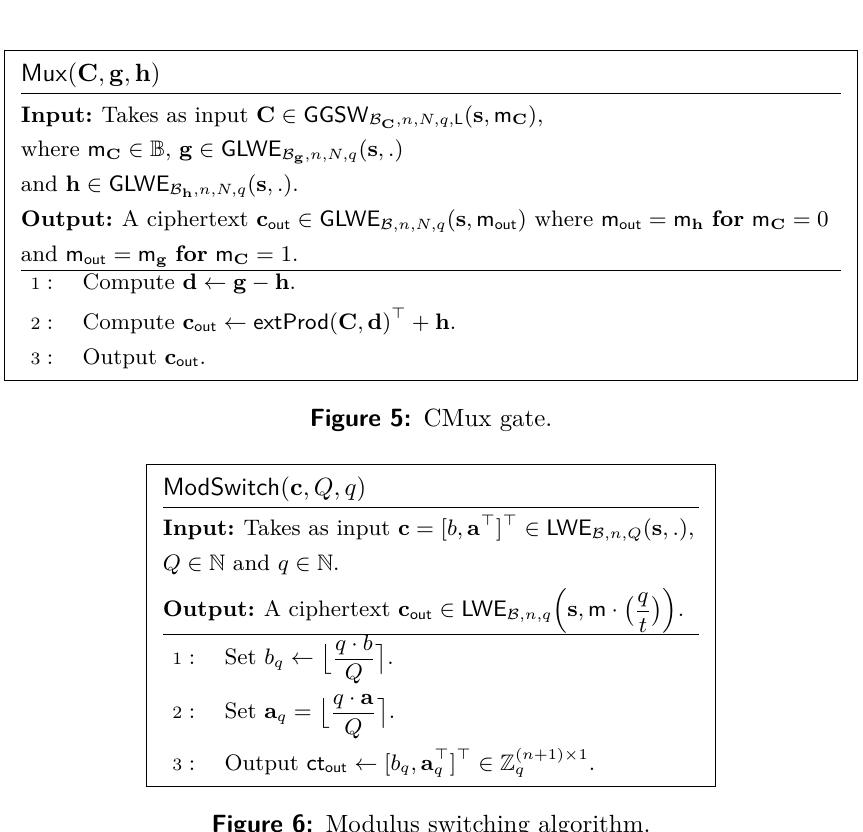
Figure 6: Modulus switching